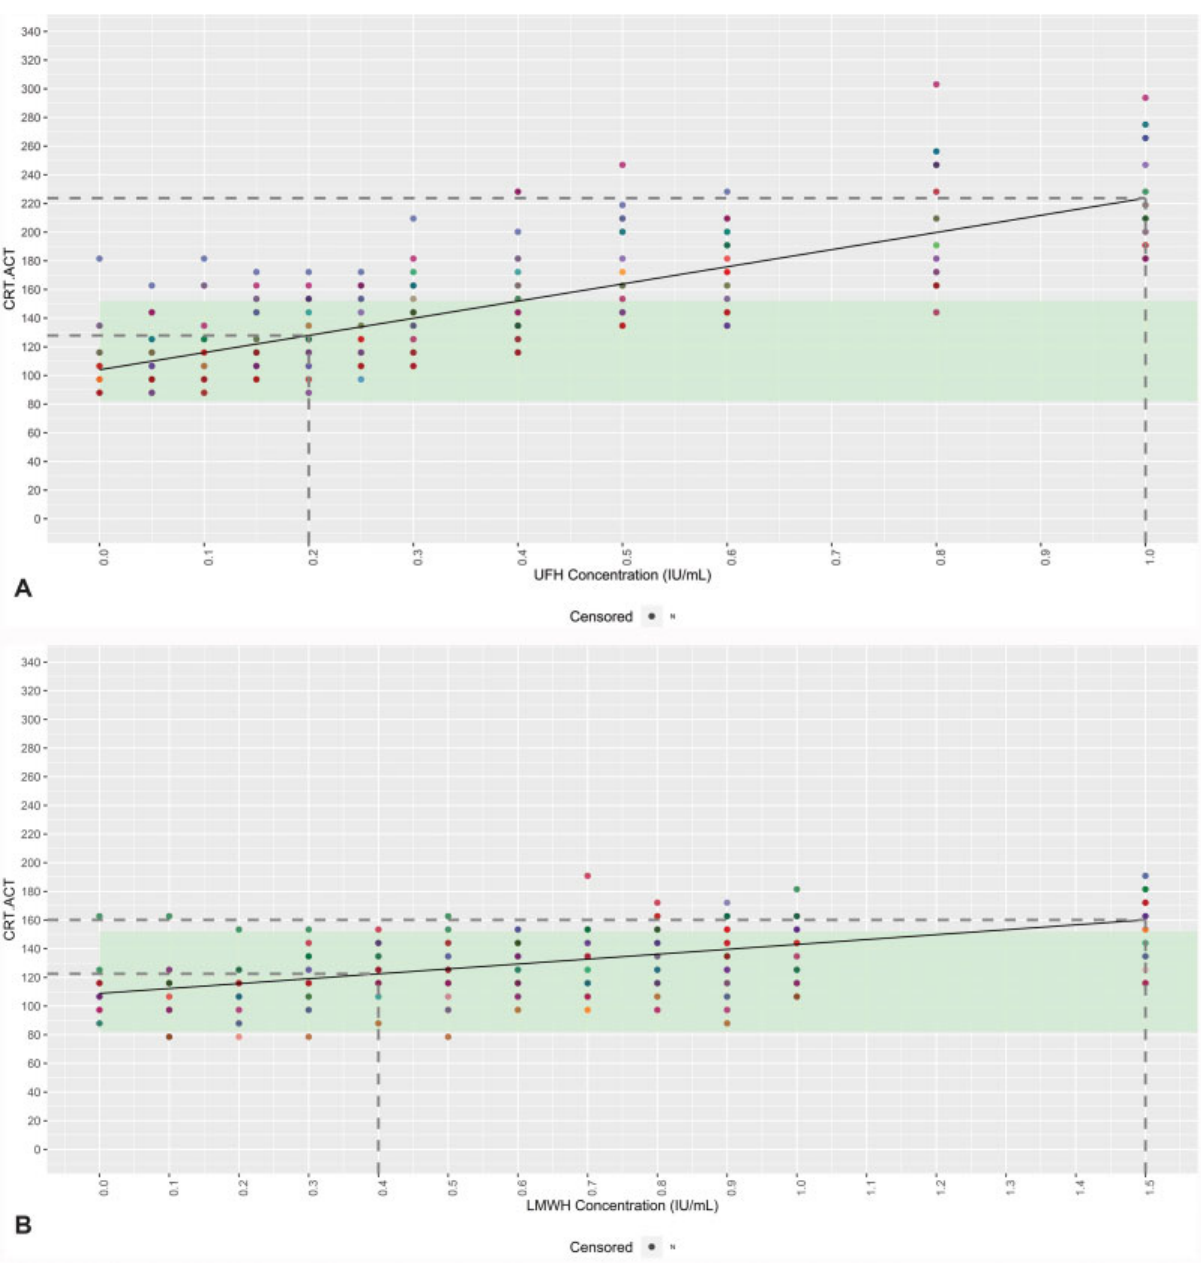
Fig. 3 Linearmixed-effectsmodelofCRT.ACTorCFF.MAinrelationtotheUFH( A )orLMWH( B )concentration.Individualdonorsarehighlightedindifferent colors,withthemodel( blackline )included.Referencerangelimitsareshownin lightgreen .The dottedlines representtheminimumandmaximumvalues( fi rst dosewheretheresponsewasstatisticallysigni fi cantfromthedose0responseorlastdosewheretheresponsewasstatisticallydifferentfromthelastobserved dosein the model, respectively). Values greater than60arebeyond thelimitofdetection,andsoare markedascensored.ACT, activatedclottingtime; CFF, citrated functional fi brinogen; CRT, RapidTEG; LMWH, low-molecular-weight heparin; MA, maximum amplitude; UFH, unfractionated heparin.